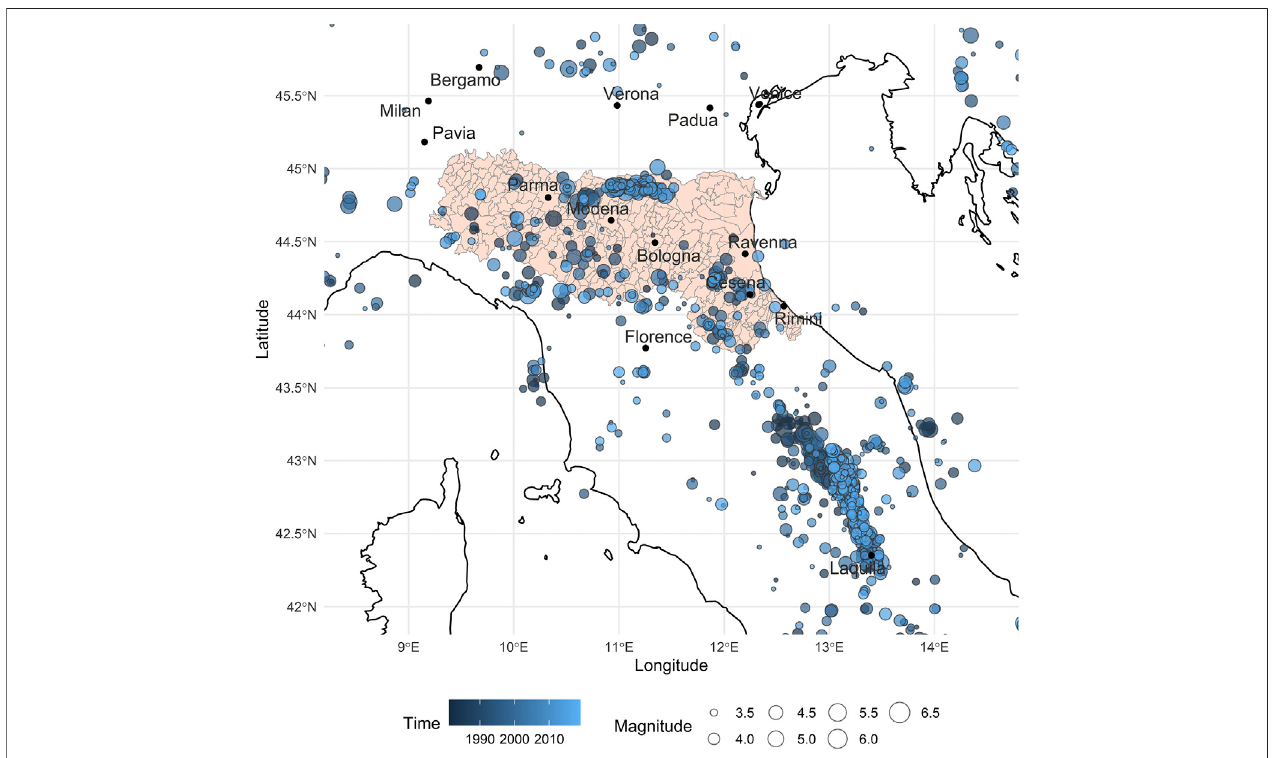
FIGURE 1 | Earthquake distribution in centre-north Italy from 1981 to 2018. The L ’ Aquila sequence is visible in the bottom-right corner of the map. In Emilia- Romagna (shaded, inset), earthquakes mostly follow the Apennines ridge but some events also occurred on foothills (between Rimini and Ravenna) and fl at lands of Po Valley (all the top part of the region). The light blue concentration below Verona is the 2012 earthquake series. Municipality boundaries are shown in